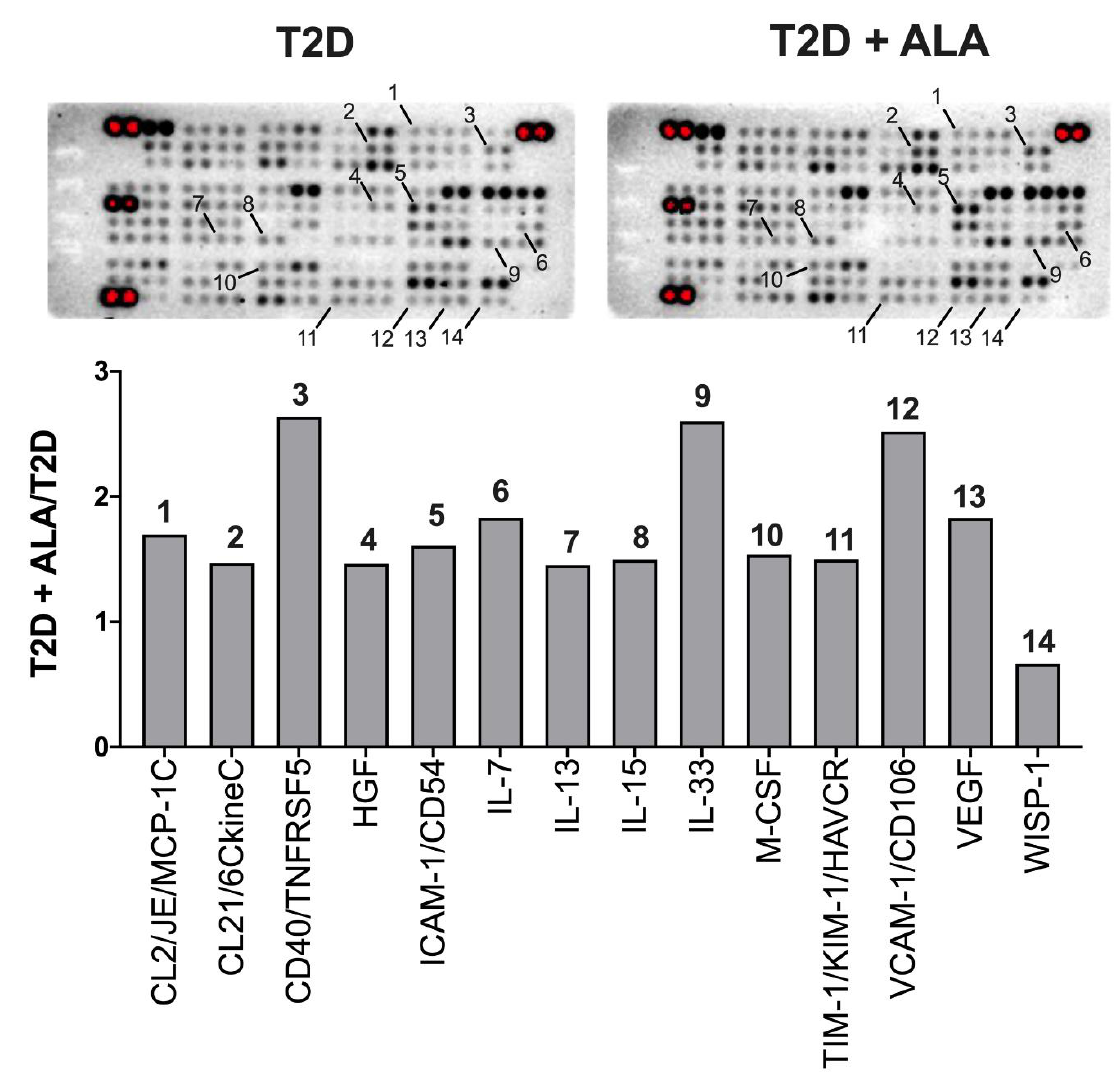
Figure 7. Inflammatory protein expression profiles in ventricular myocardium from T2D mice ± dietary ALA supplementation. Data are shown for analytes with ± 50% change in relative expression in left ventricles from ALA-supplemented T2D mice, compared to un-supplemented T2D mice. Analytes on membranes (in duplicate; upper panel) are labeled with numbers corresponding to bars on graph (lower panel). Results presented as a ratio (T2D ALA:T2D).